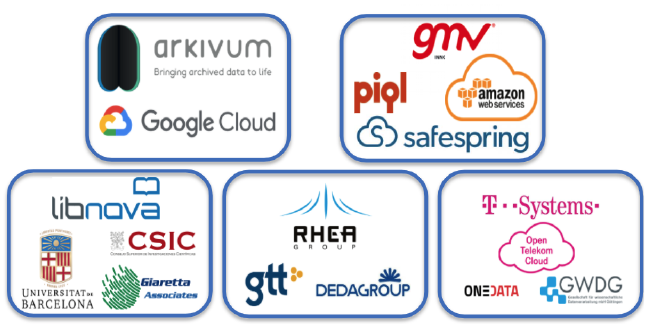
Fig. 3. Consortia participating in the ARCHIVER Design Phase .